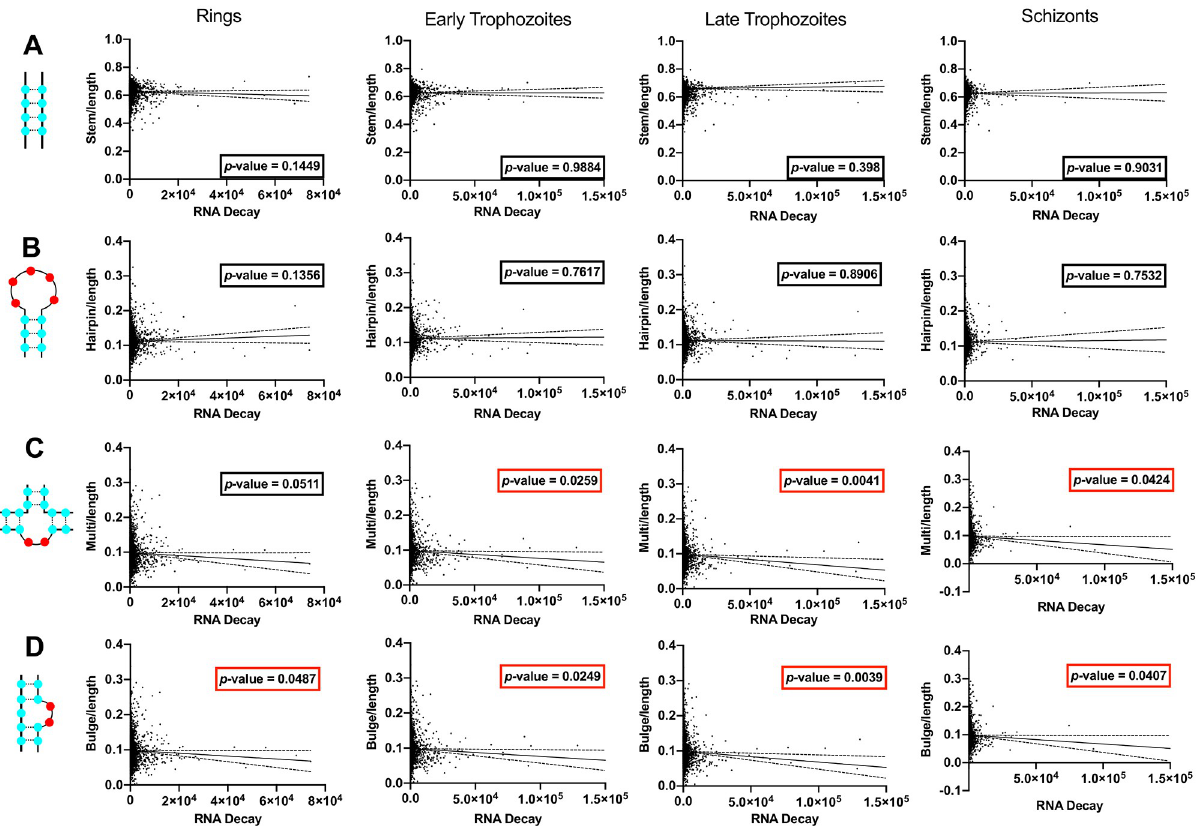
Fig 6. Correlation between RNA secondary structures and RNA decay across the erythocytic cycle of P . falciparum . The columns represent the different erythrocytic stages of P . falciparum and the rows represent the correlation between RNA decay and (A) the number of stems, (B) the number of hairpins, (C) the number of multi-stem loops and (D) the number of bulges. Statistically significant negative correlations have a p -value framed in red.